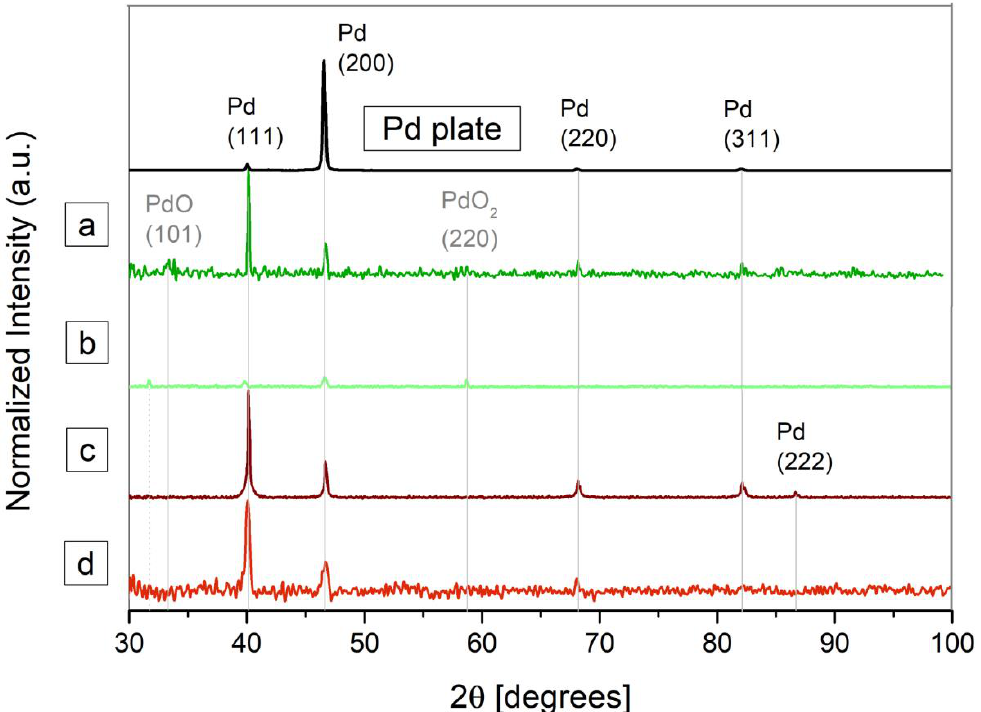
Figure 6. XRD of the palladium target and palladium nanoparticles synthesized by laser ablation with ( a ) 532 nm of wavelength in water, ( b ) 532 nm in methanol, ( c ) 1064 nm in water and ( d ) 1064 nm in methanol, comparing the diffraction pattern of the palladium plate used as target. The position of the representative diffraction peaks is indicated by the gray lines.